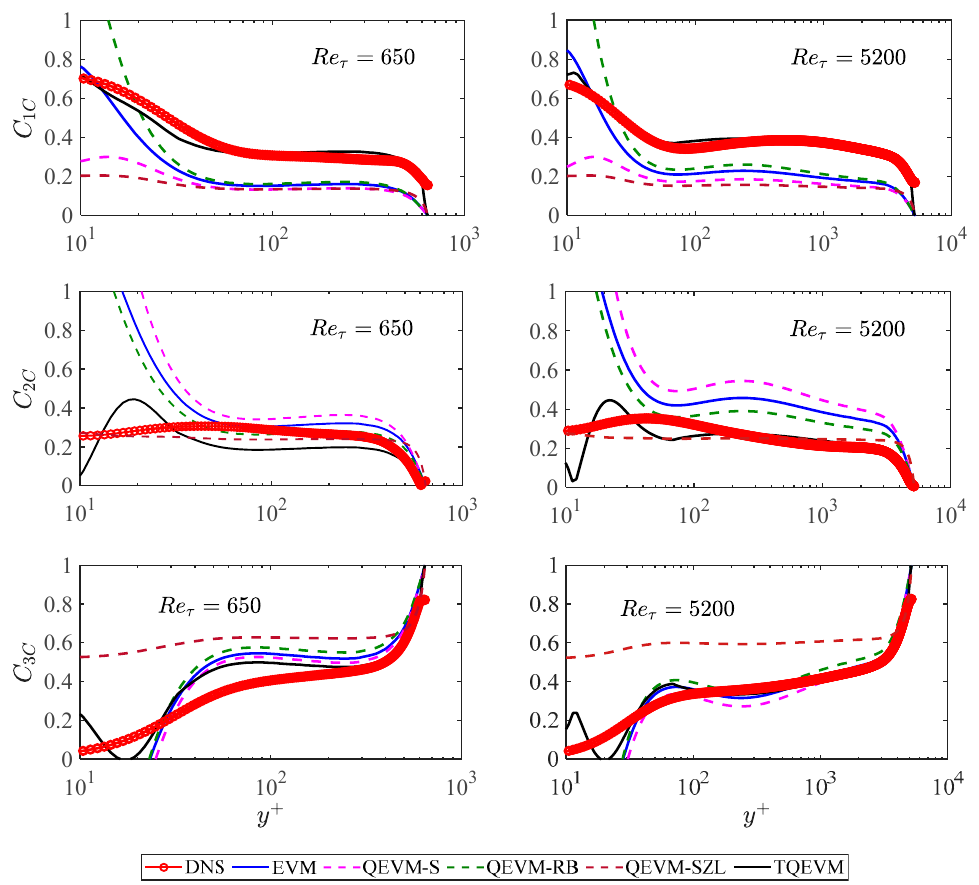
Figure 10. Weights ( C 1 C , C 2 C , C 3 C ) of anisotropy states at a given point for Re τ = 650 ( left ) and Re τ = 5200 ( right ) obtained from DNS, EVM, QEVM-S, QEVM-RB, QEVM-SZL, and the proposed TQEVM. The first three rows correspond to C 1 C , C 2 C , and C 3 C , respectively.